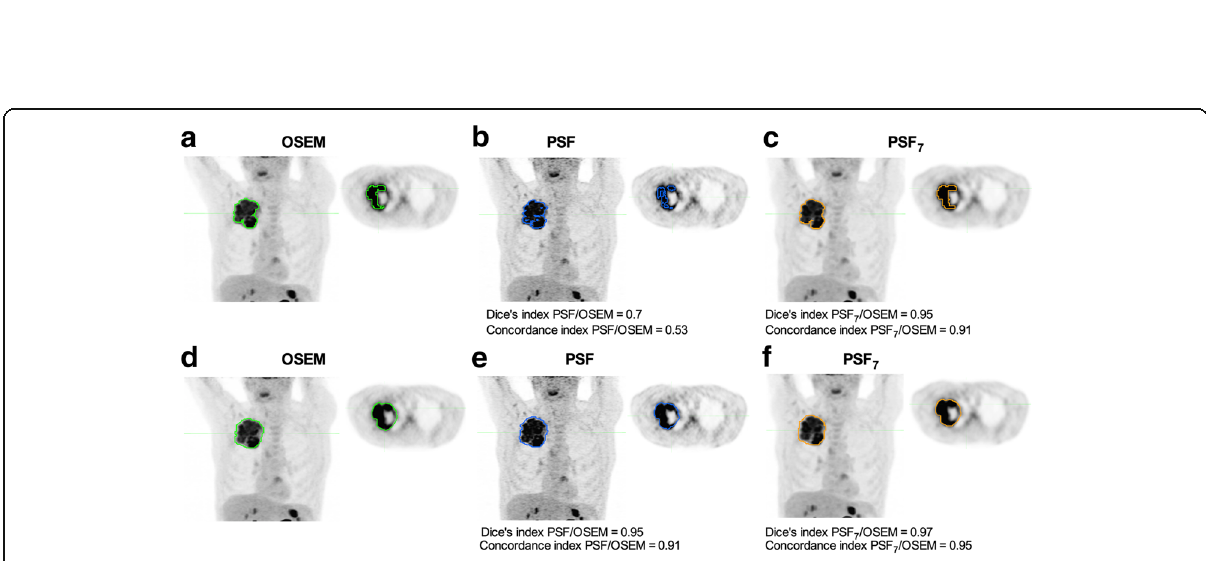
Fig. 6 Representative images of isocontour- and gradient-based automatic contouring of PSF images optimised for diagnostic and EARL- compliant purposes. Maximum intensity projections and transverse slices at the level of a necrotic tumour in the right upper lobe of the lung are shown for OSEM, unfiltered PSF images, and PSF images filtered to meet EARL requirements (PSF 7 ). Dice and concordance indices are given for each contouring method, using the MATV extracted from the OSEM images as a reference